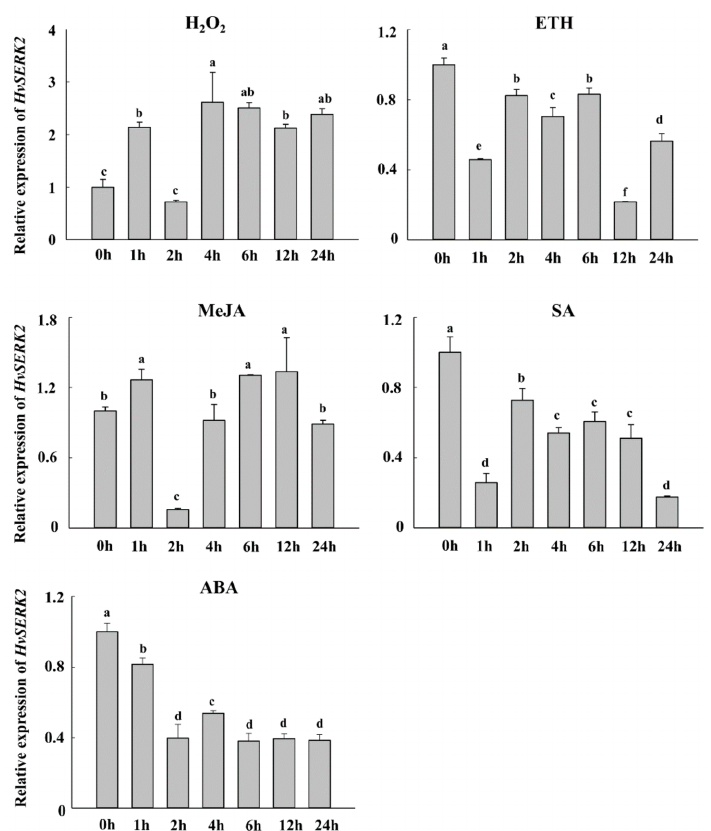
Figure 4. Expression profiles of HvSERK2 in response to hydrogen peroxide (H 2 O 2 ), ethephon (ETH), methyl jasmonate (MeJA), and salicylic (SA) treatments by quantitative RT-PCR. Expression profiles of HvSERK2 in leaves of barley upon treatment with H 2 O 2 (7 mM), ETH (200 mM), MeJA (0.1 mM), SA (5 mM), an dabscisic acid (ABA) (0.2 mM), respectively. The actin gene was used as an internal control to normalize qRT-PCR values. Different letters indicate statistically significant differences ( p < 0.05, one-way